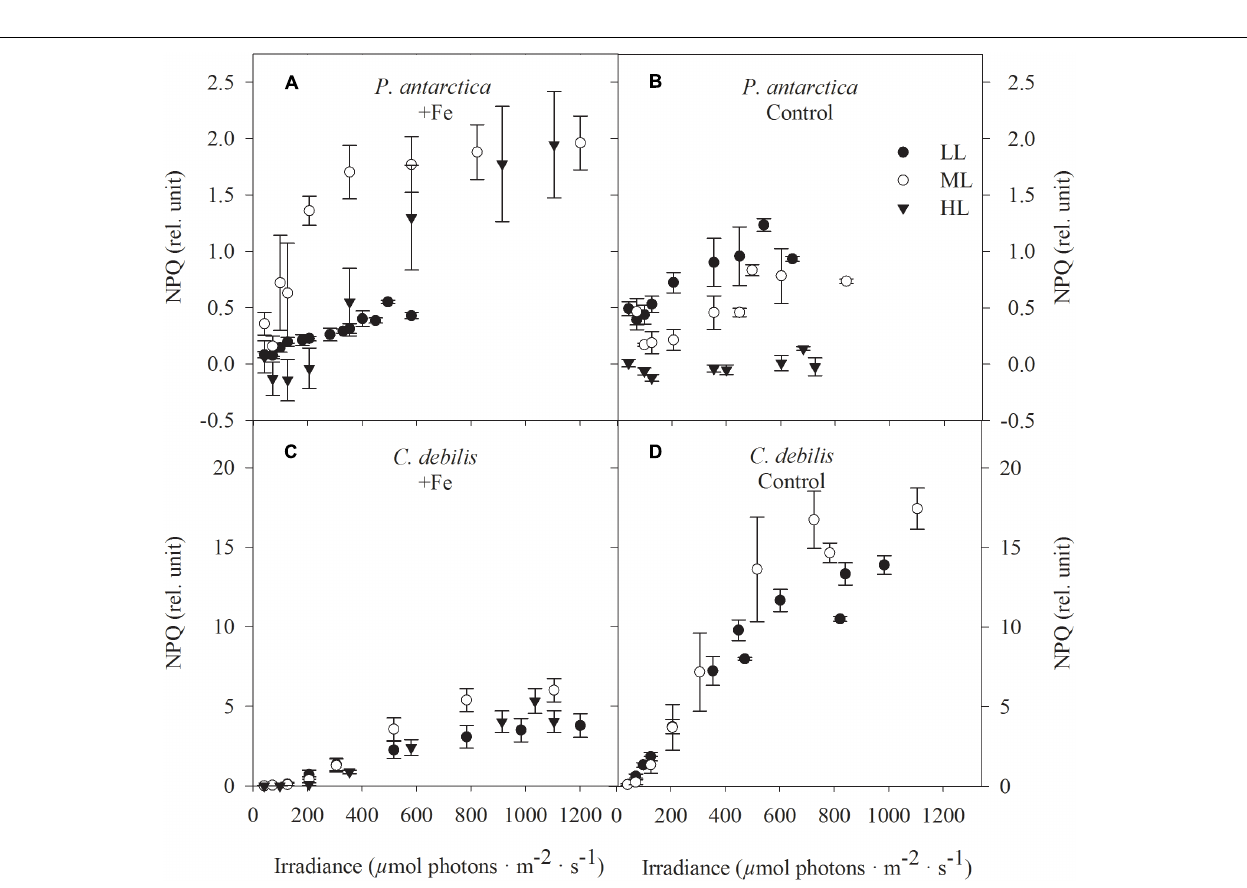
FIGURE 5 | Nonphotochemical quenching (NPQ) was determined in response to increasing irradiance in (A,B) P. antarctica and (C,D) C. debilis acclimated to Fe-enriched (A,C) and control (B,D) conditions combined with low (LL, filled circle), medium (ML, open circle) and high (HL, triangles) light. NPQ was obtained in three individual measurements. Values represent the means ± SD ( n = 3). Different letters indicate significant differences between treatments ( p < 0.05).